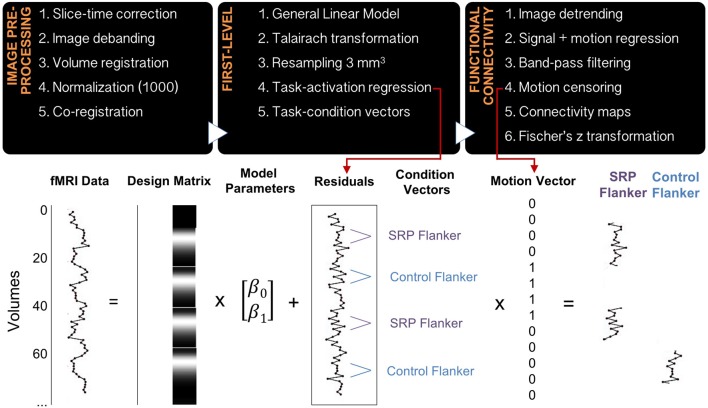
Data preprocessing and analysis pipeline. The diagram includes the steps for image preprocessing, first-level analysis and function connectivity analysis (top), as well as a schematic of a general linear model being applied to the raw imaging data and residual time courses undergoing additional preprocessing, motion censoring and grouping into epochs that represent SRP and Control Flanker blocks (bottom). Averages of similar epochs were used to create functional connectivity maps.